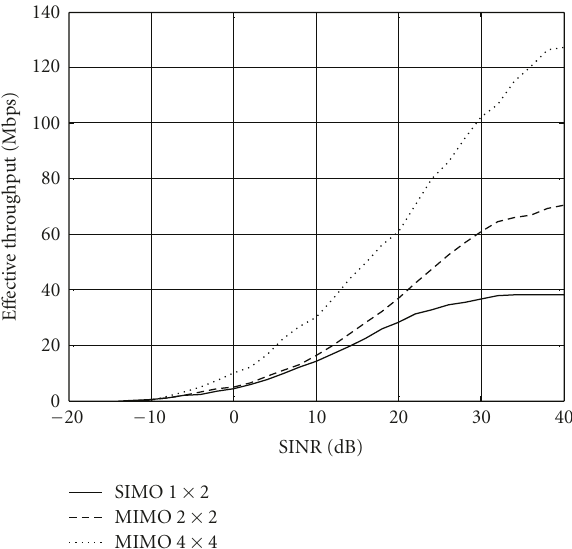
Figure 3: Link level evaluation of throughput versus SINR in LTE downlink.